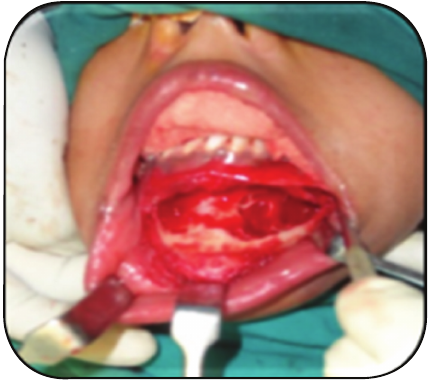
Figure 8: Intraoperative enucleation.